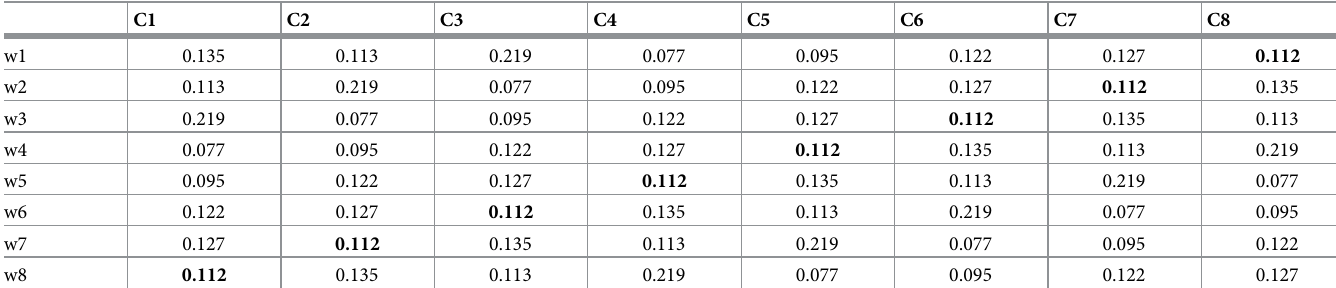
Table 8. Criteria weight distribution scenarios.